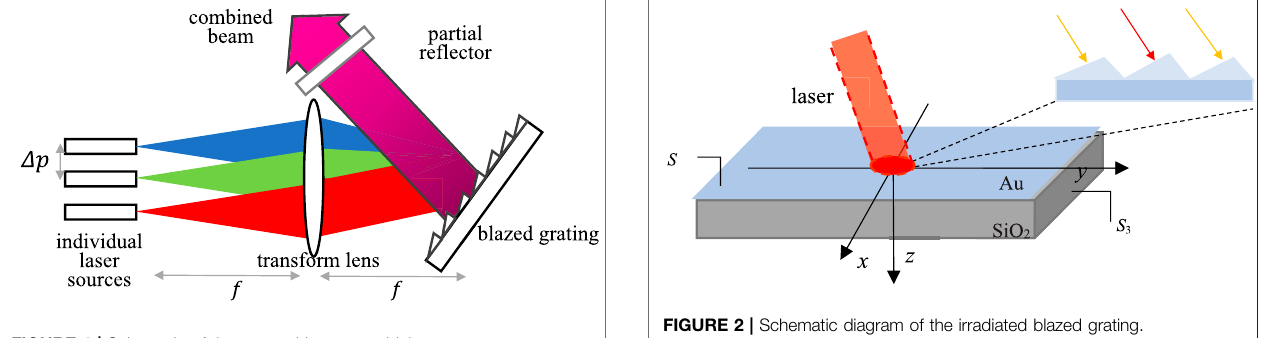
FIGURE 1 | Schematic of the spectral beam combining.